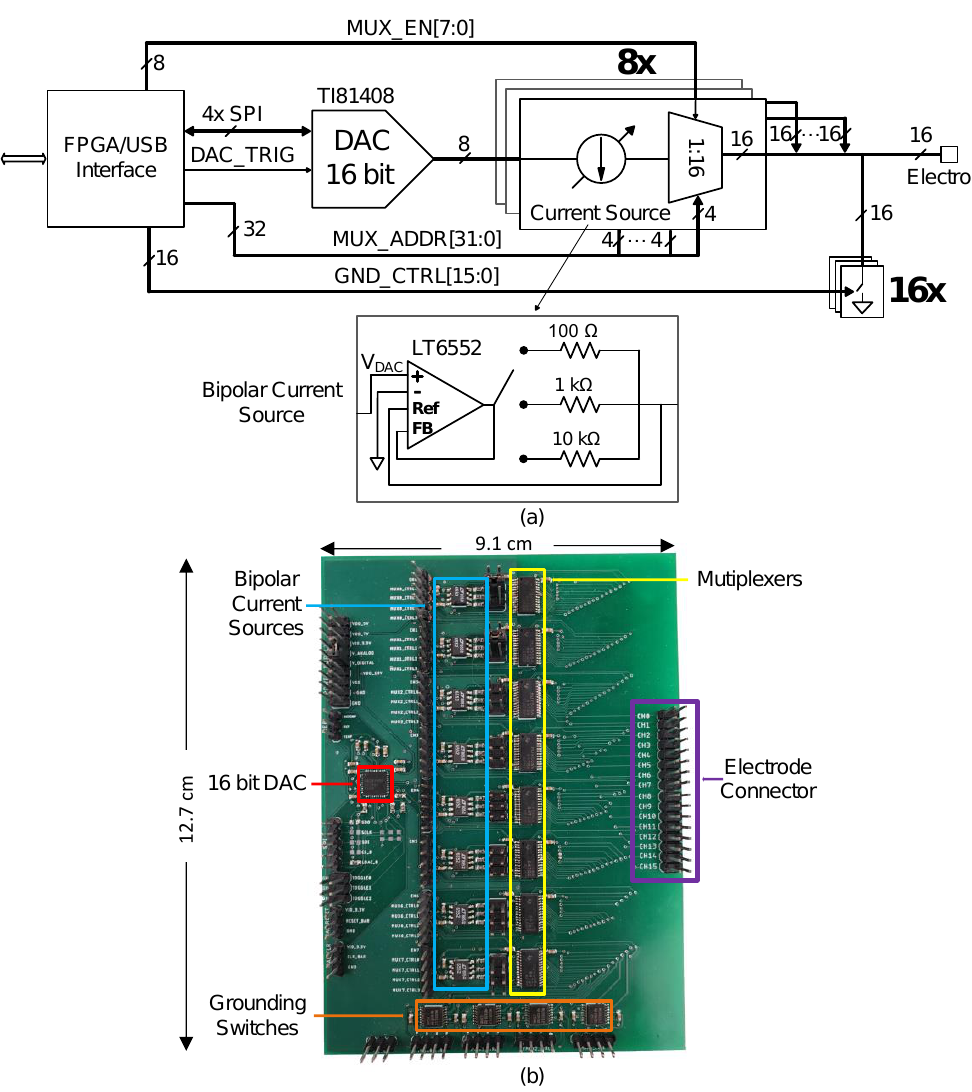
Figure 1. ( a ) System architecture and ( b ) implemented